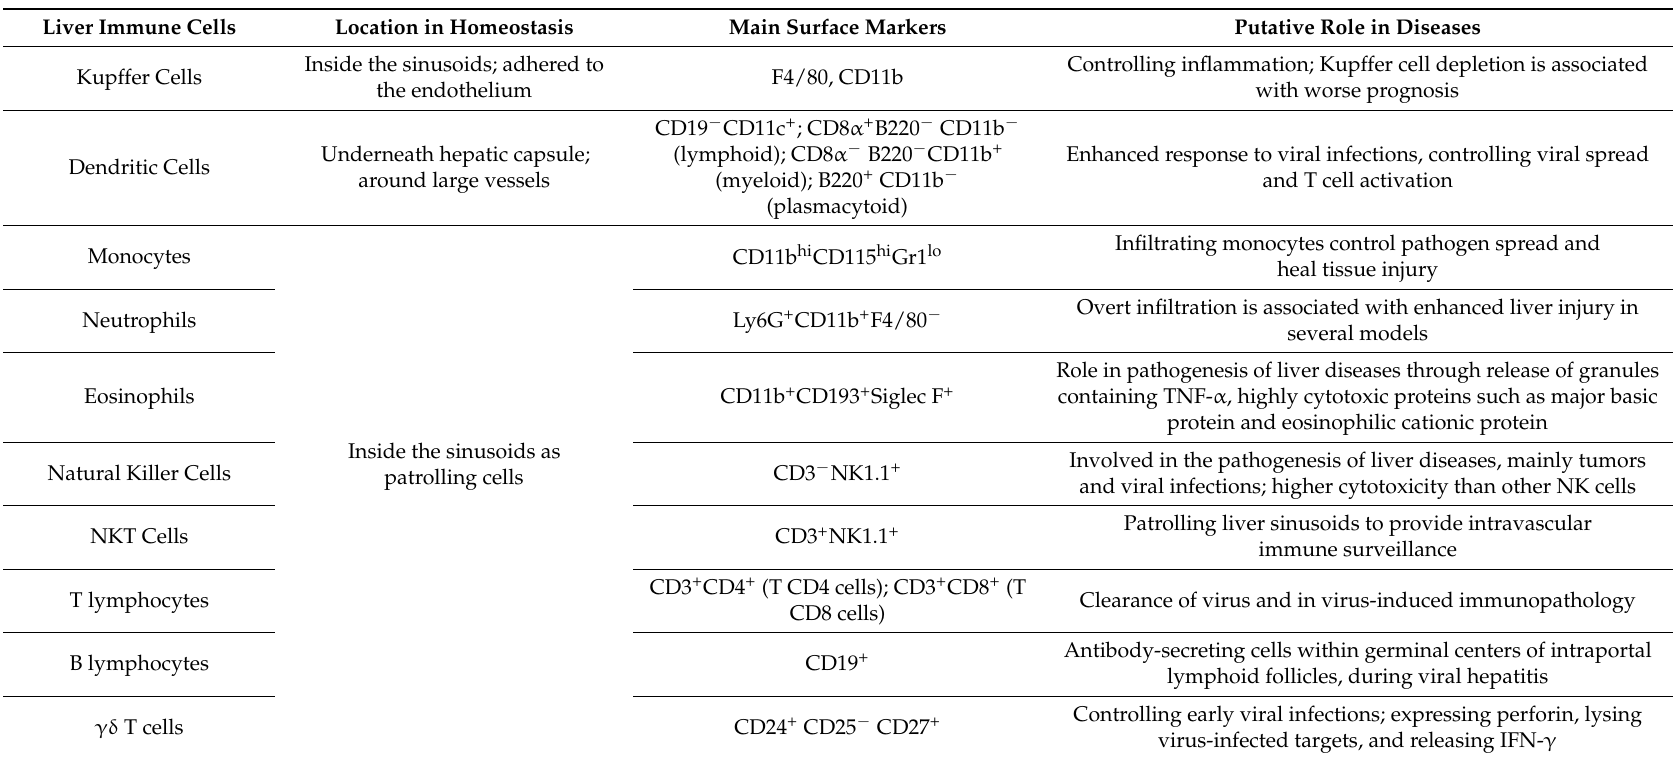
Table 1. Liver immune